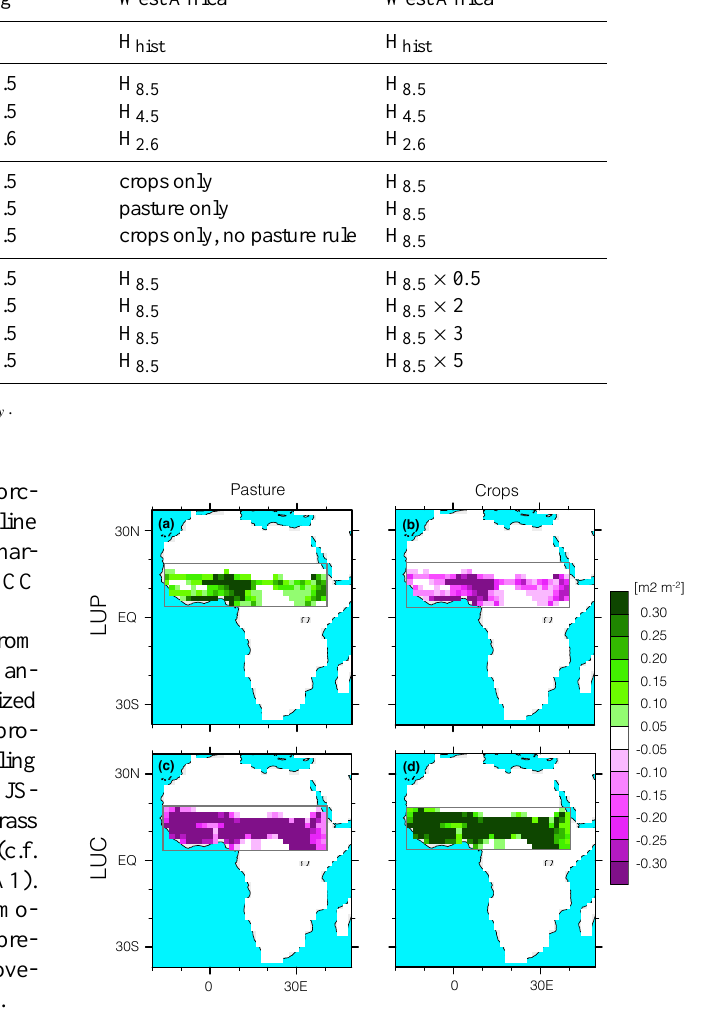
Figure 1. Spatial distribution of pasture (a) and crop (d) land use Fig. 4: Spatial distribution of strong anthropogenic land use transitions in pasture (left at the end of the historic simulation. The panel also shows the pre- column) and cr ops (right column) within the first year (2006) of the land use scribed transitions from crops to pasture (scenario LUP; first row) experiments LUP (top row) and LUC (bottom row). and vice versa (scenario LUC, LUCnoPR; bottom row) for the first model year (2006) in the extreme land use experiments LUP, LUC, and